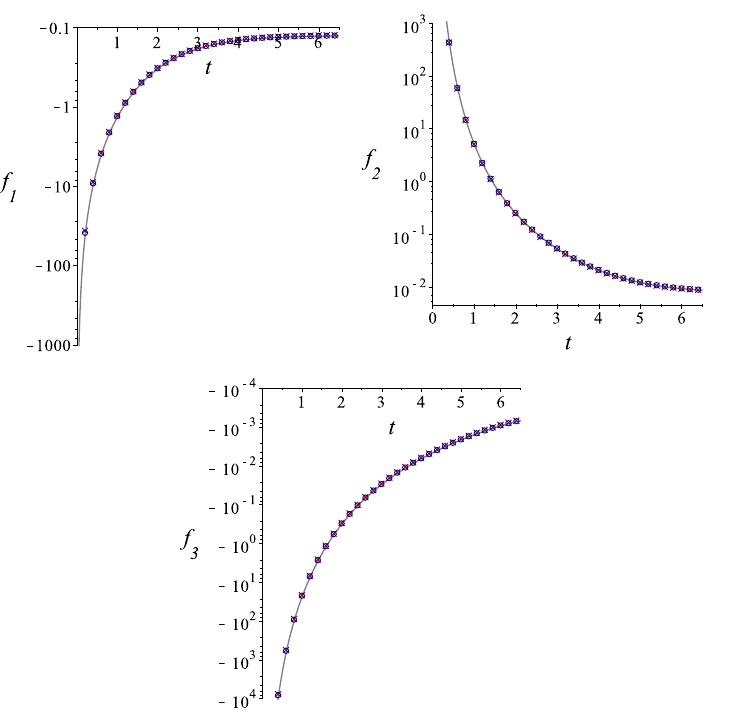
Figure 3 . Asymptotic sequences versus analytic expressions of f n ( t ) ; n = 1 ; 2 ; 3. Red diagonal crosses represent f n; 60 ( t ) (4.8), while blue circles represent the (cid:12)rst Richardson transforms f (1) Gray solid lines are the plots of analytic expressions (4.22).